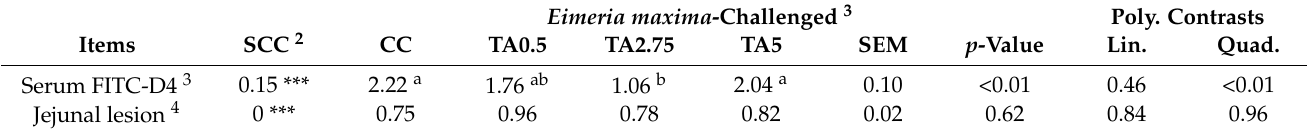
Table 6. Effects of tannic acid supplementation on serum FITC D4 concentration and Eimeria maxima lesion in broiler chickens infected with Eimeria maxima at 5 days post-infection (dpi) and 6 dpi, respectively 1